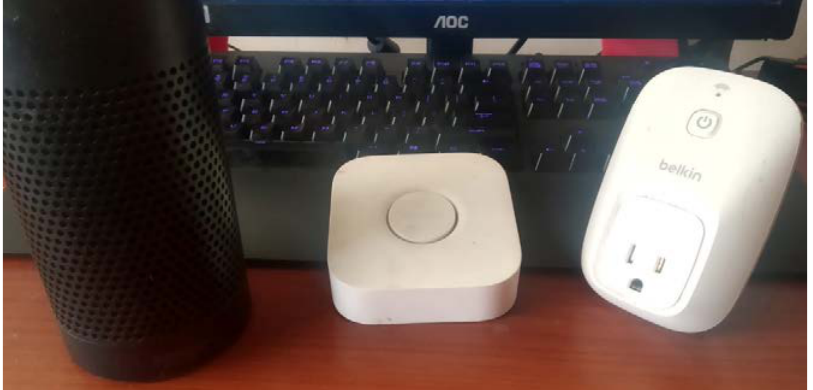
Figure 14. Smart home based on medium-cost